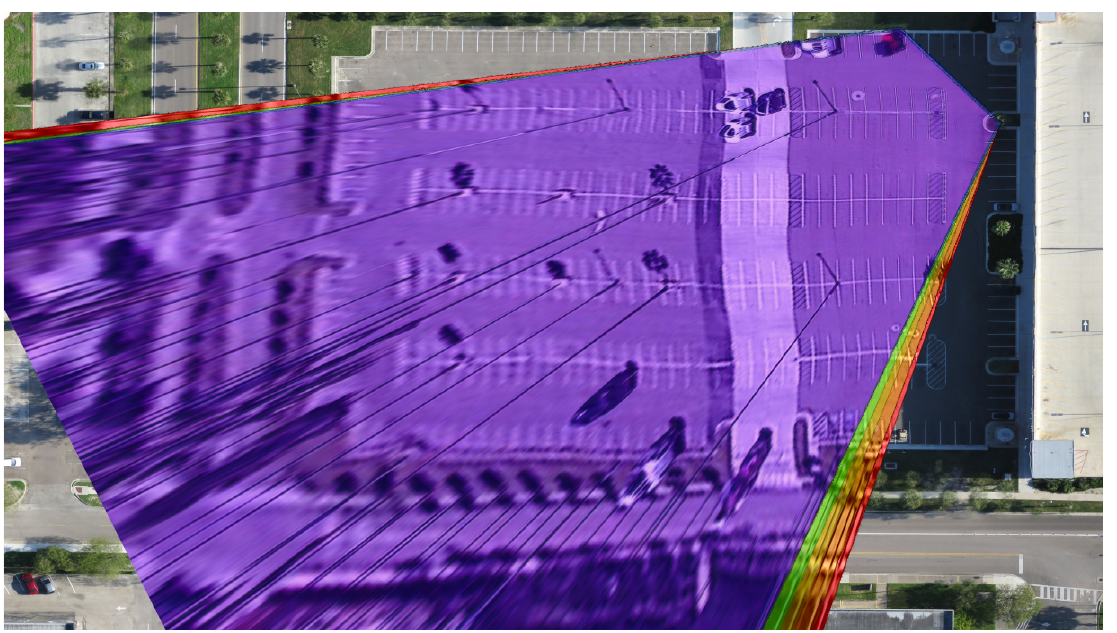
Figure 7. The results of using the recursively larger groups of points outlined in Figure 5 to reproject the perspective image into the aerial orthoimage plane. Note the distinct linear deformation in some of the lateral parking space lines as well as variable degrees of alignment to the parking lot borders and the bottom interior row of parking spaces around the edge.